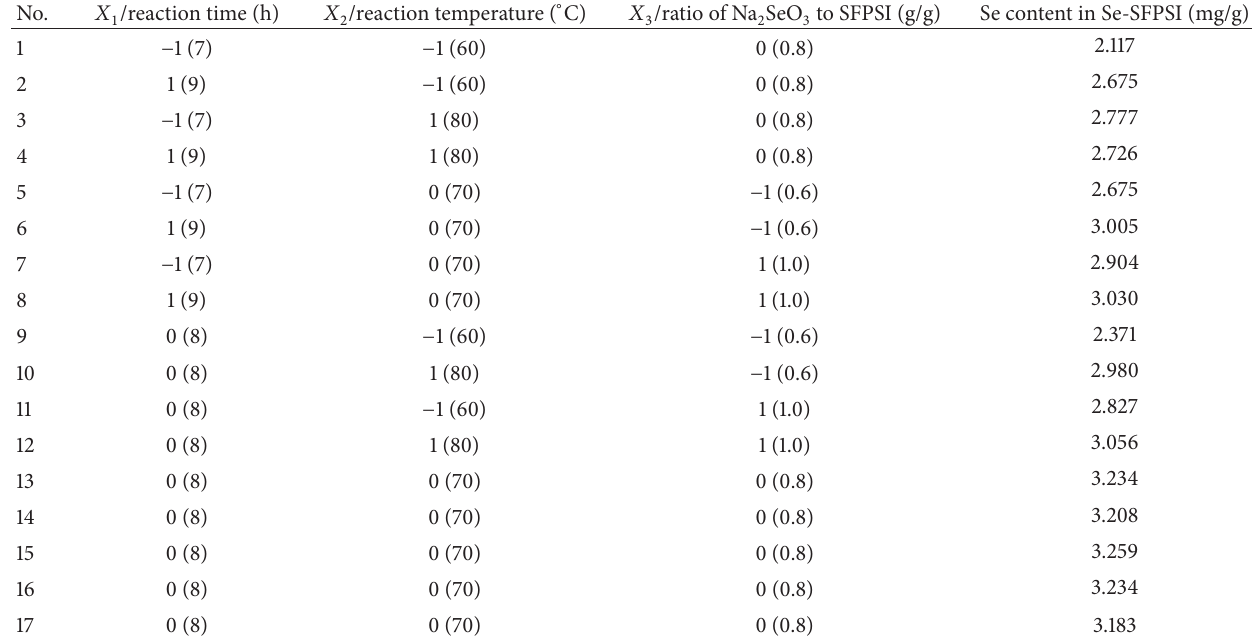
Table 2: Box-Behnken design of three variables and the experimental results.